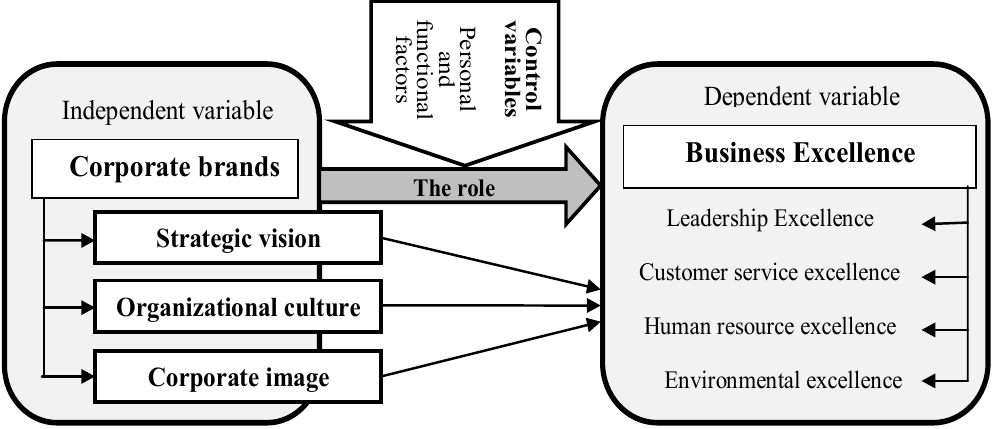
Fig. 1. The hypothetical model of the